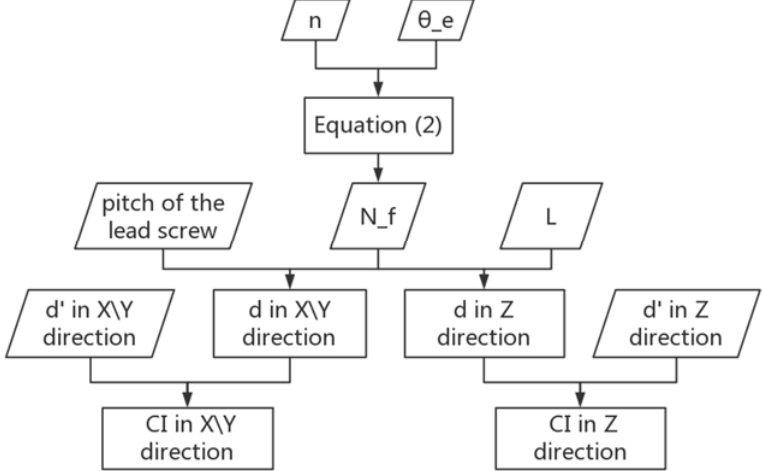
Figure 3. Flowchart of the algorithm for minimizing out-of-step errors of three stepper motors.